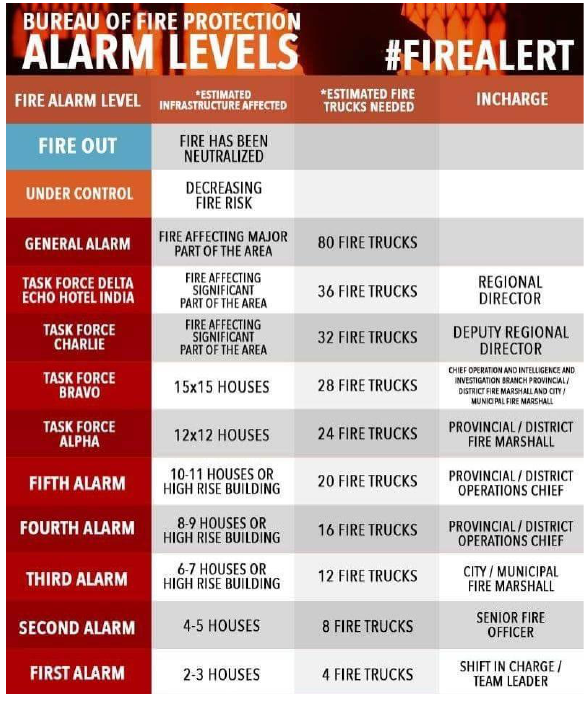
Figure 3 . An infographic provided by the BFP indicating estimates of affected buildings and fire